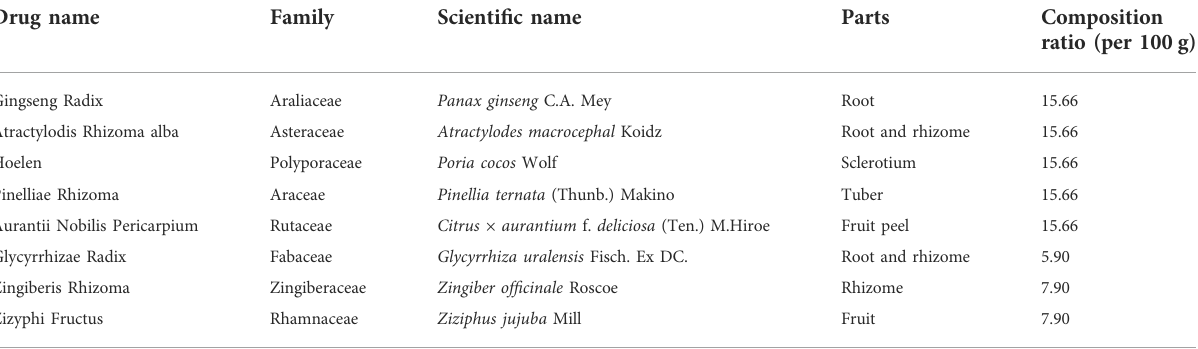
TABLE 1 The Complete species and drug name of Yuk-gunja-tang (YG) and it is the composition